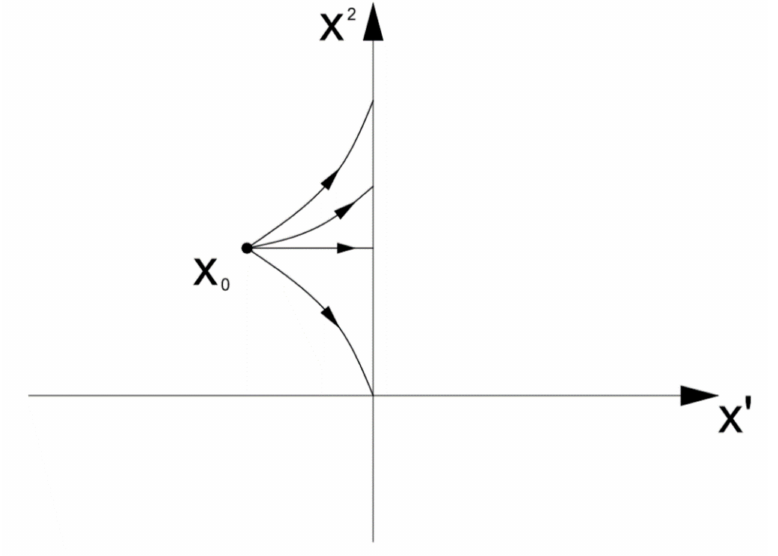
Figure 6. Different control